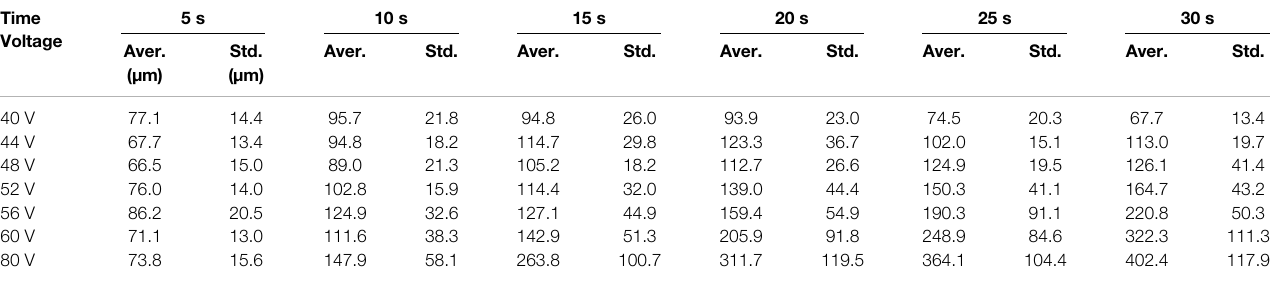
TABLE 1 | Droplet size on the heater surface was measured over time during atomization. Time 5 s 10 s Voltage